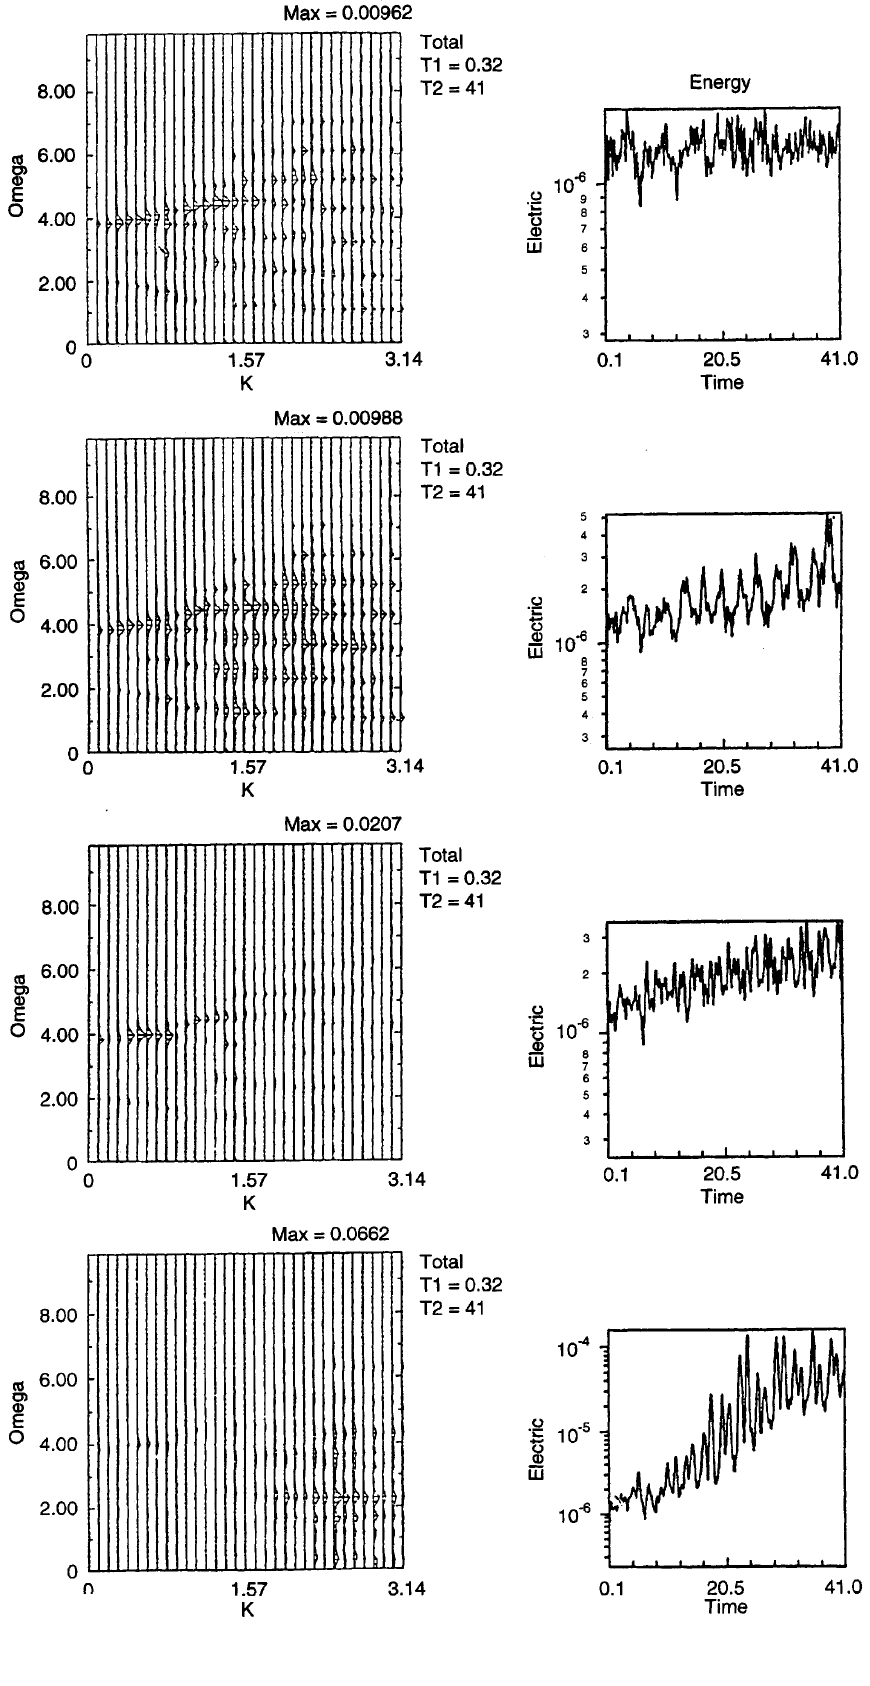
Fig. 7. Simulation results for the four basic runs: real dispersion diagram ( left panel ) and temporal evolution of the wave electric field energy density ( right panel ). From top to bottom: runs G, F, P, and PF; energy density with